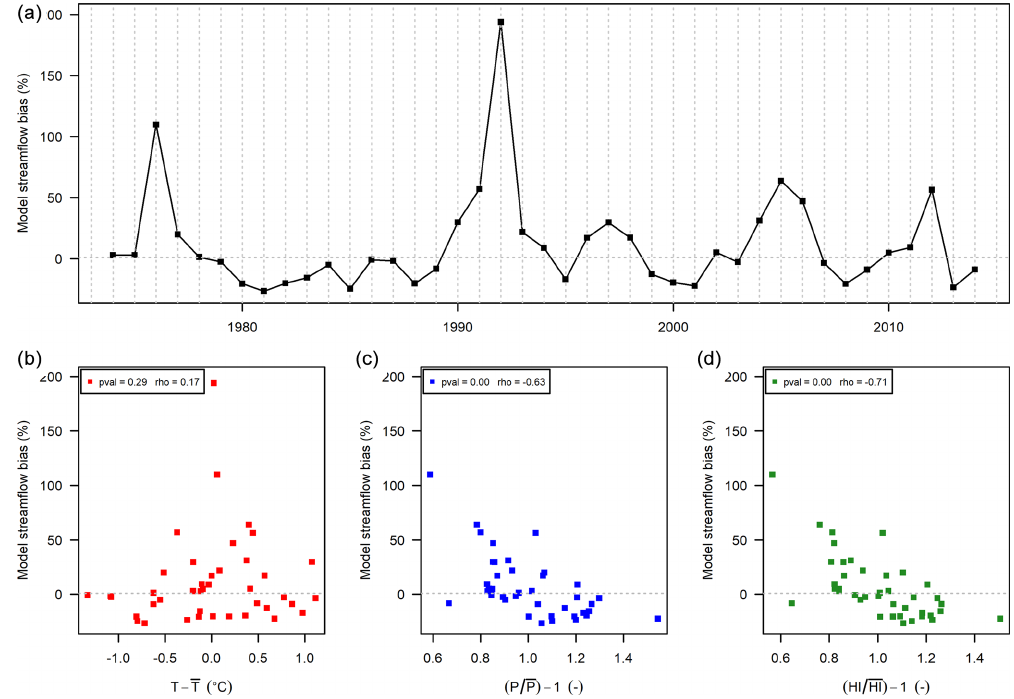
Figure 8. Streamflow annual bias obtained with the RAT function of time (a) , temperature absolute anomalies (b) , and precipitation P (c) and humidity index P/E 0 (d) anomalies, for the Seiche River at Bruz (J7483010) (810km 2 ).